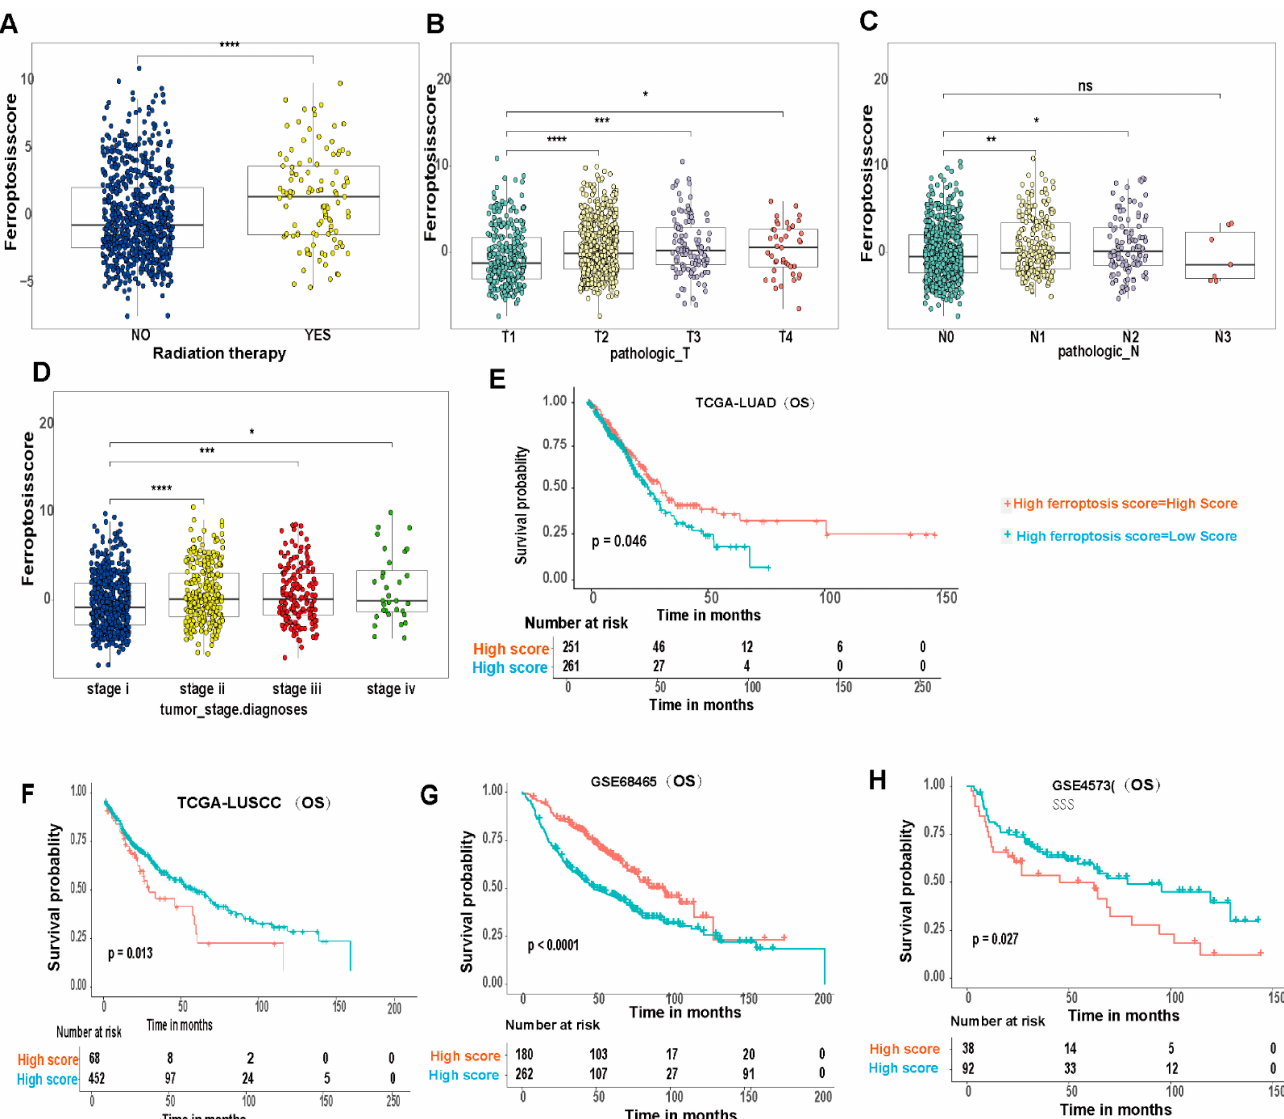
Figure 7. Clinical and genetic variation analyses of ferroptosis score and model validation. ( A ) The distribution of ferroptosis scores in distinct patients who did or did not receive radiation therapy in the NSCLC datasets. ( B , C ) The distribution of ferroptosis scores in the TN stages in the NSCLC datasets. ( D ) The distribution of ferroptosis scores across different diagnosis stages in the NSCLC datasets. ( E ) Kaplan–Meier plots for OS in the high and low ferroptosis score groups based on TCGA-LUAD. ( F ) Kaplan–Meier plots for OS in the high and low ferroptosis score group based on TCGA-LUSCC. ( G ) Kaplan–Meier plots for OS in the high ferroptosis score group and low ferroptosis score group based on GSE 68465. ( H ) Kaplan–Meier plots for OS in the high and low ferroptosis score group based on GSE4573 (* p < 0.05; ** p < 0.01; *** p < 0.001, **** p <